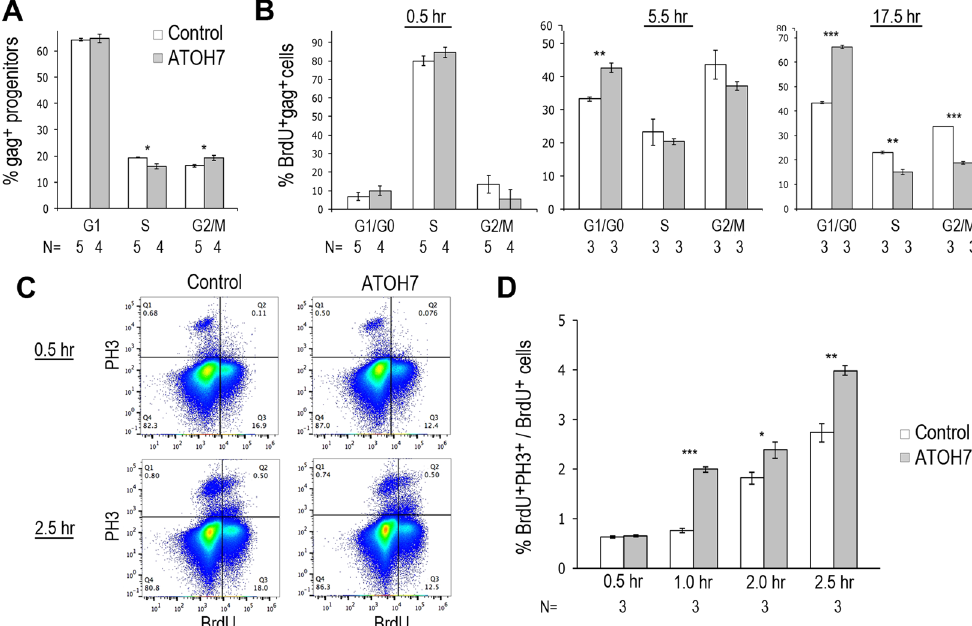
Figure 6. Effects of ATOH7 expression on cell cycle progression and exit. ( A ) Distribution of virally infected progenitors in different phases of the cell cycle. Retinas were infected at stage 17 and immunolabeling at stage 32 for postmitotic neuron markers, including Islet-1, NF68, Visinin, Brn3a, and AP2 α− positive cells. The neuronal marker-positive cells were excluded, and the remaining progenitor populations were analyzed based on their DNA contents, with 2n cells as G1-phase cells, 4n cells as G2/M-phase cells, and those between 2n and 4n as S-phase cells. ( B ) Cell cycle progression of virus infected progenitors. Retinas were infected at stage 10, pulse labeled with BrdU at stage 30. Bar graphs show distribution of BrdU and gag double positive cells at 0.5- hour, 5.5-hour, and 17.5-hour post BrdU labeling in different phase of the cell cycle based on DNA contents. ( C , D ) Progression of progenitor cells from S-phase to M-phase. Retinas were infected with viruses at stage 10 and pulse labeled with BrdU at stage 30. The infection rates for the control virus and ATOH7 viruses were 75% and 54%, respectively. ( C ) Flow cytometry profiles of BrdU and PH3 double positive cells at 0.5-hour and 2.0-hour after BrdU pulse-labeling. ( D ) Bar graph shows BrdU and PH3 double positive M phase cells among BrdU-labeled cells at different time intervals. Numbers of independent samples analyzed are indicated below the bar graphs. Error bars indicate SEM. * p < 0.05; ** p < 0.01; *** p <